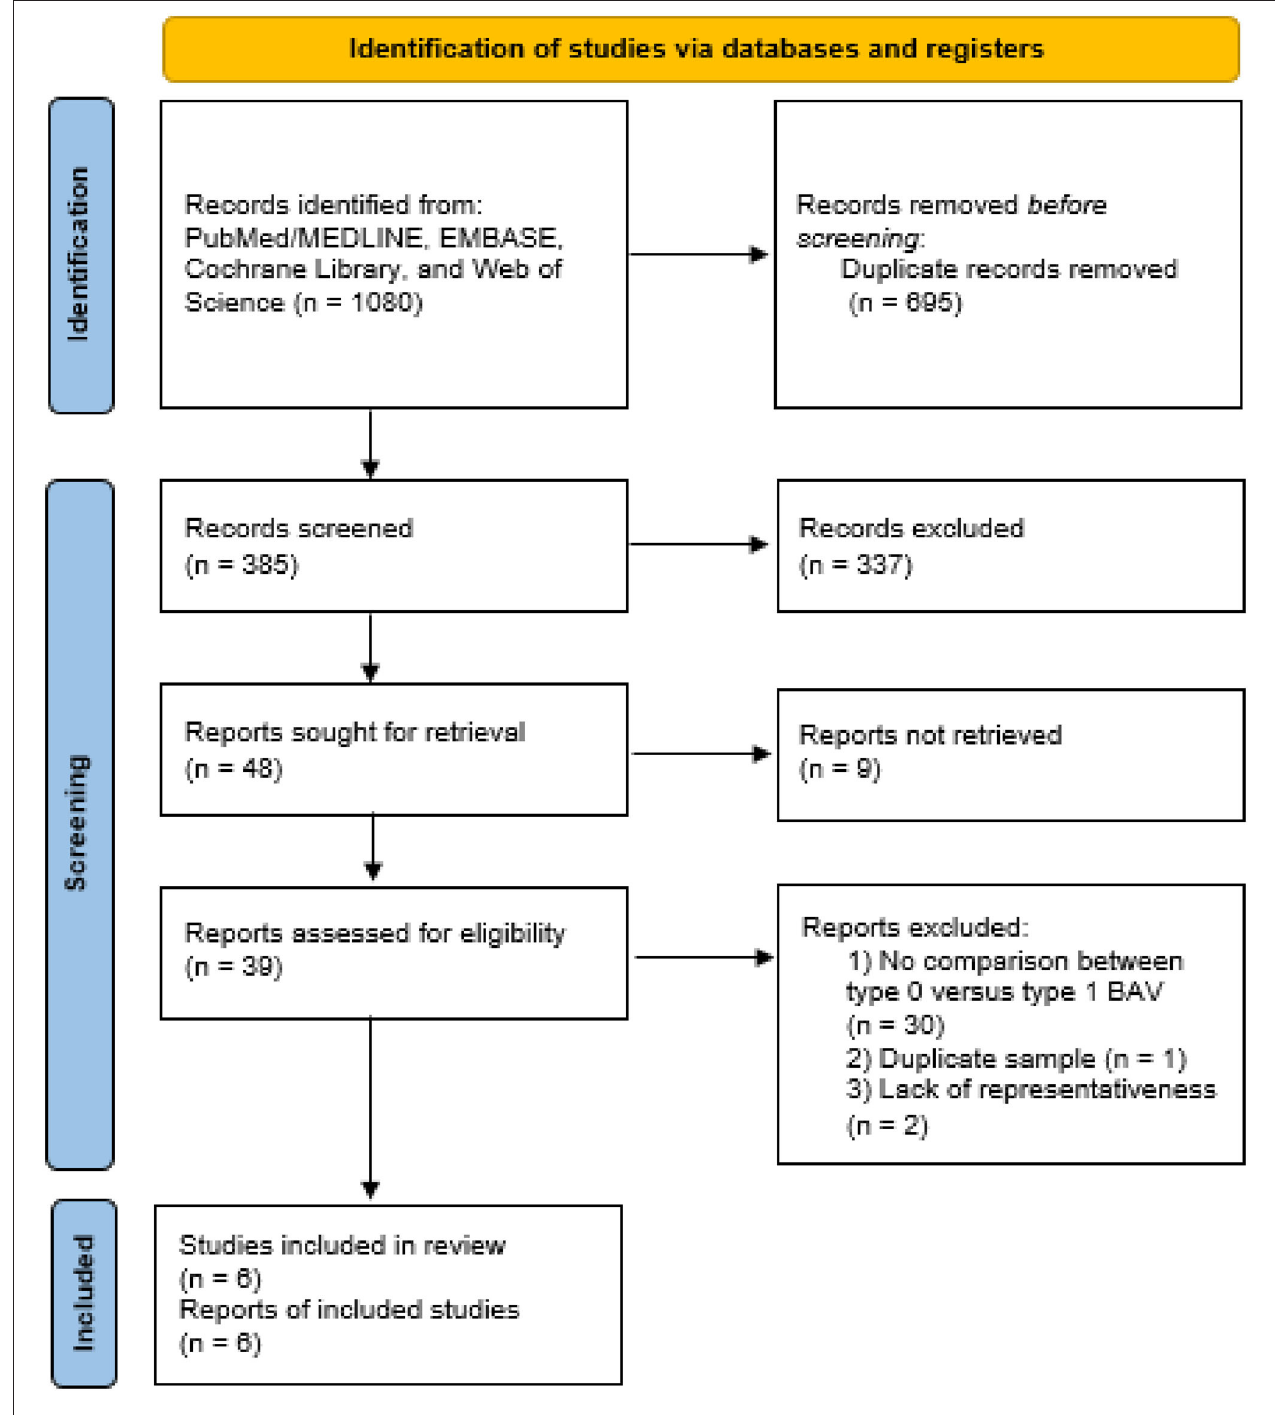
FIGURE 1 | Study inclusion flowchart. BAV, bicuspid aortic